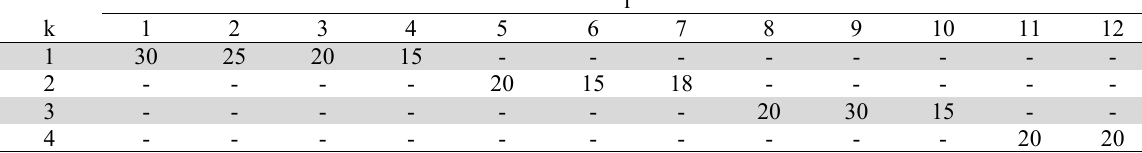
Distance between distribution centers and retailers(d kl )